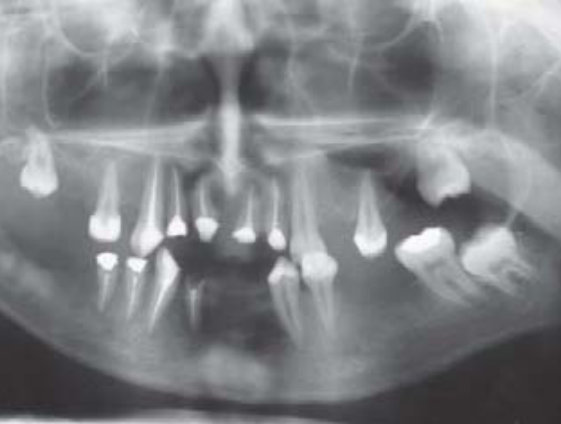
Figure 4- Panoramic radiograph taken 6 months after the endodontic treatment. Note a remarkable decrease of the